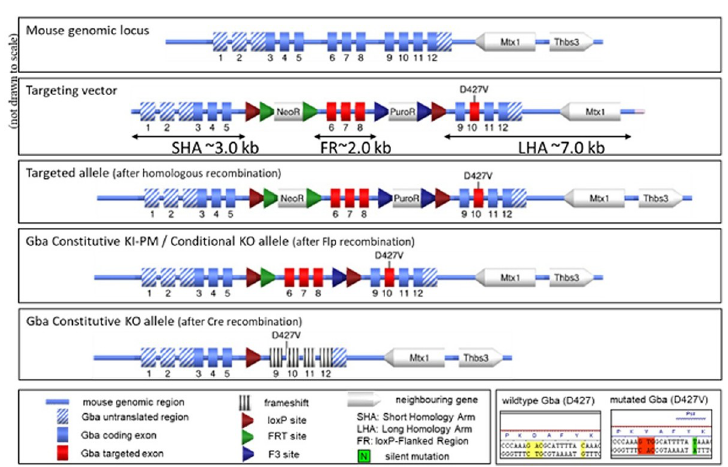
Fig 1. Schematic depiction of GBA1 targeting strategy. The GBA1 D409V KI mutation was introduced to the murine Gba1 gene through the constitutive knockin (KI) of a Gba1 D427V point mutation as the D427V mutation corresponds to the D409V mutation in the mature GCase protein (Xu et al, 2003). The targeting vector was designed to introduce the D427V point mutation and an additional silent mutation to generate a Psil restriction site for analytical purposes. Positive selection markers were flanked by FRT (Neo R ) and F3 (Puro R ) sites respectively. Following homologous recombination in embryonic stem (ES) cells and selection by double positive resistance to neomycin and puromycin, resistant clones were validated for correct integration. Validated ES cells were injected into blastocysts to generate chimers. Chimeric male animals were crossed to FLP recombinase-expressing females to remove the selection cassettes. The resulting animals express the GBA1 D427V point mutation corresponding to the D409V point mutation in mature protein. An additional feature of this model is the insertion of LoxP sites flanking exons 6–8. After Cre recombination, the murine GBA1 gene will be constitutively knocked out as a result of loss of gene function through deletion of part of the GCase domain and introduction of a frameshift from exon 5 to all downstream exons with a premature stop codon in exon